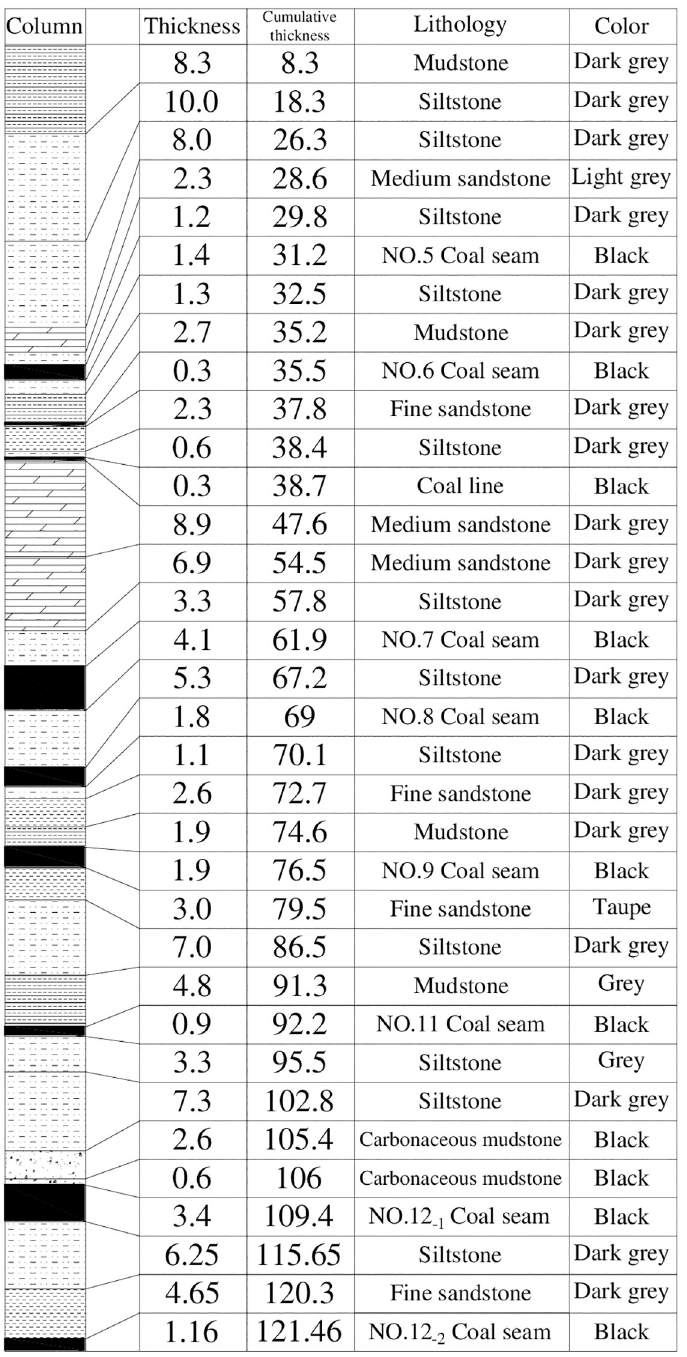
Fig 6. Coal-bearing strata in Qianjiaying coal